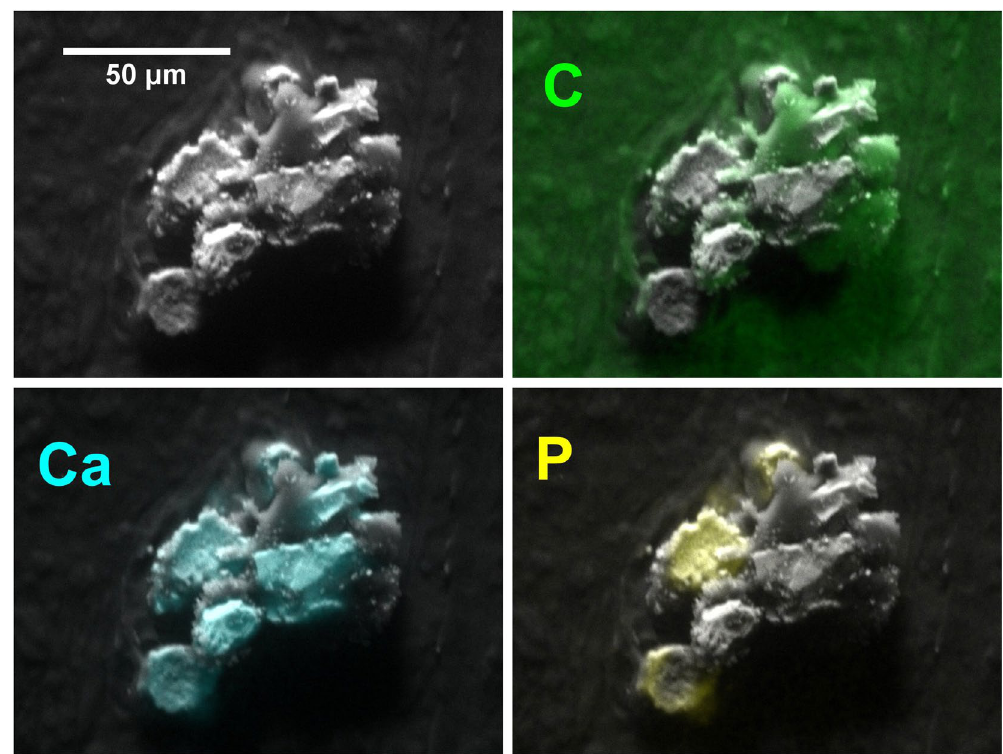
Figure 3. SEM image of a calcification with low phosphorus regions corresponding to a non-apatite phase. (Specimen S66 – pathology details in Supplementary Table